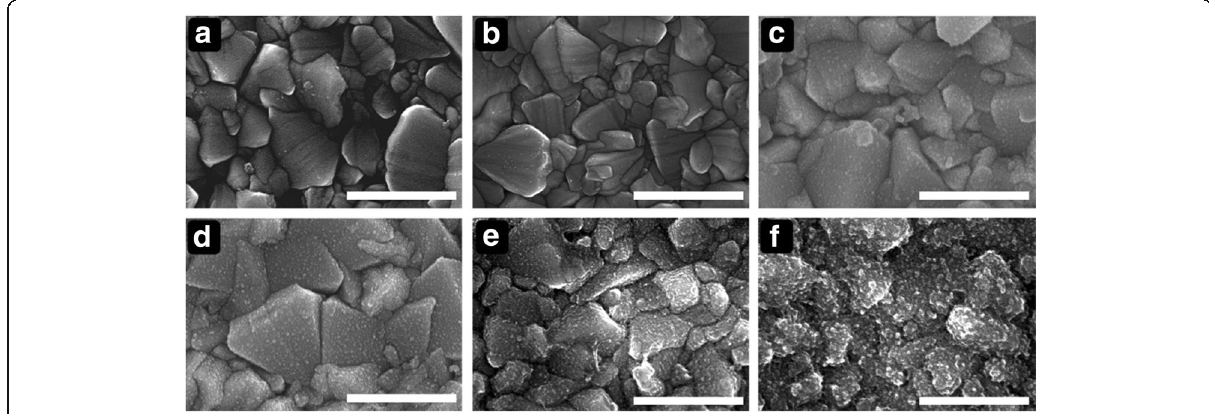
Fig. 2 Top-view SEM images of SnO 2 films electrodeposited at various applied voltages. ( a ) − 0.5 V, ( b ) − 0.6 V, ( c ) − 0.7 V, ( d ) − 0.8 V, ( e ) − 0.9 V, and ( f ) − 1.0 V vs. Ag/AgCl. Scale bar is 1 μ